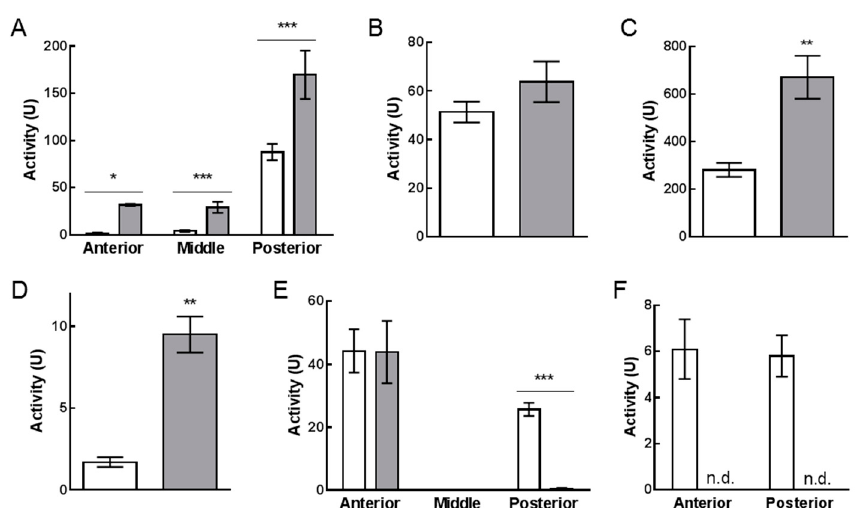
Figure 2. Enzymatic activities in midgut juice ( A – C , E , F ) or midgut homogenate ( D ) from larvae reared on SD (white bars) and VMD (grey bars). Total proteolytic activity in midgut juice extracted from anterior, middle, and posterior midgut ( A ). Trypsin- ( B ) and chymotrypsin- ( C ) like activity in midgut juice extracted from posterior midgut. Aminopeptidase N activity in the homogenate of posterior midgut ( D ). α -amylase activity in midgut juice extracted from anterior, middle, and posterior midgut ( E ). Lipase activity in midgut juice extracted from anterior and posterior midgut; n.d. non-detectable activity ( F ). The values are reported as mean ± s.e.m. of at least 3 experiments. Asterisks indicate statistically significant differences between diet groups (unpaired t -test: * p -value < 0.05, ** p -value < 0.01, *** p -value < 0.001).